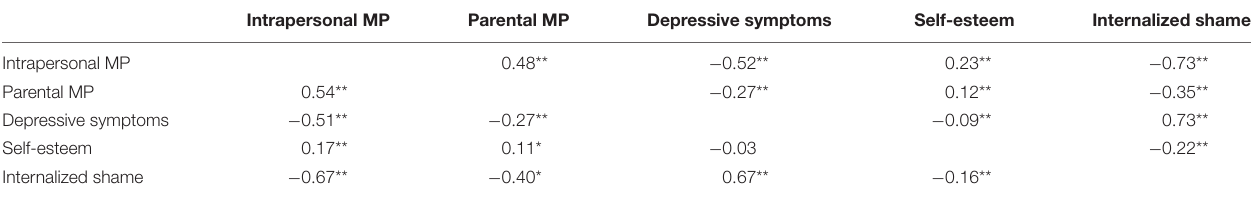
TABLE 2 | Bivariate correlations between study